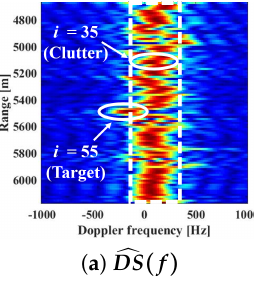
Figure 2. Doppler spectra of the target range bin and a clutter bin. Figure 2b shows two normalized Doppler spectra, ds 55 ( f ) and ds 35 ( f ) . ds 55 ( f ) , which is for the maritime target and has the highest peak at f D = − 168 Hz ( v R = 2.87 m/s using (cid:98) (cid:98) (cid:98) (16)). Meanwhile, ds 35 ( f ) , which is for the sea clutter, provides the highest peak at f D = 97 Hz ( v R = − 1.66 m/s), which is far from f D = − 168 Hz of the maritime target. (cid:98) Meanwhile, Figure 2c shows the mean Doppler spectra for each range bin with B = 33. Both ds 55 ( f ) and ds i ( f ) have a clear and high peak around f D = 97 Hz. This is because the range bins are surrounded by successive sea-waves with v R = − 1.66